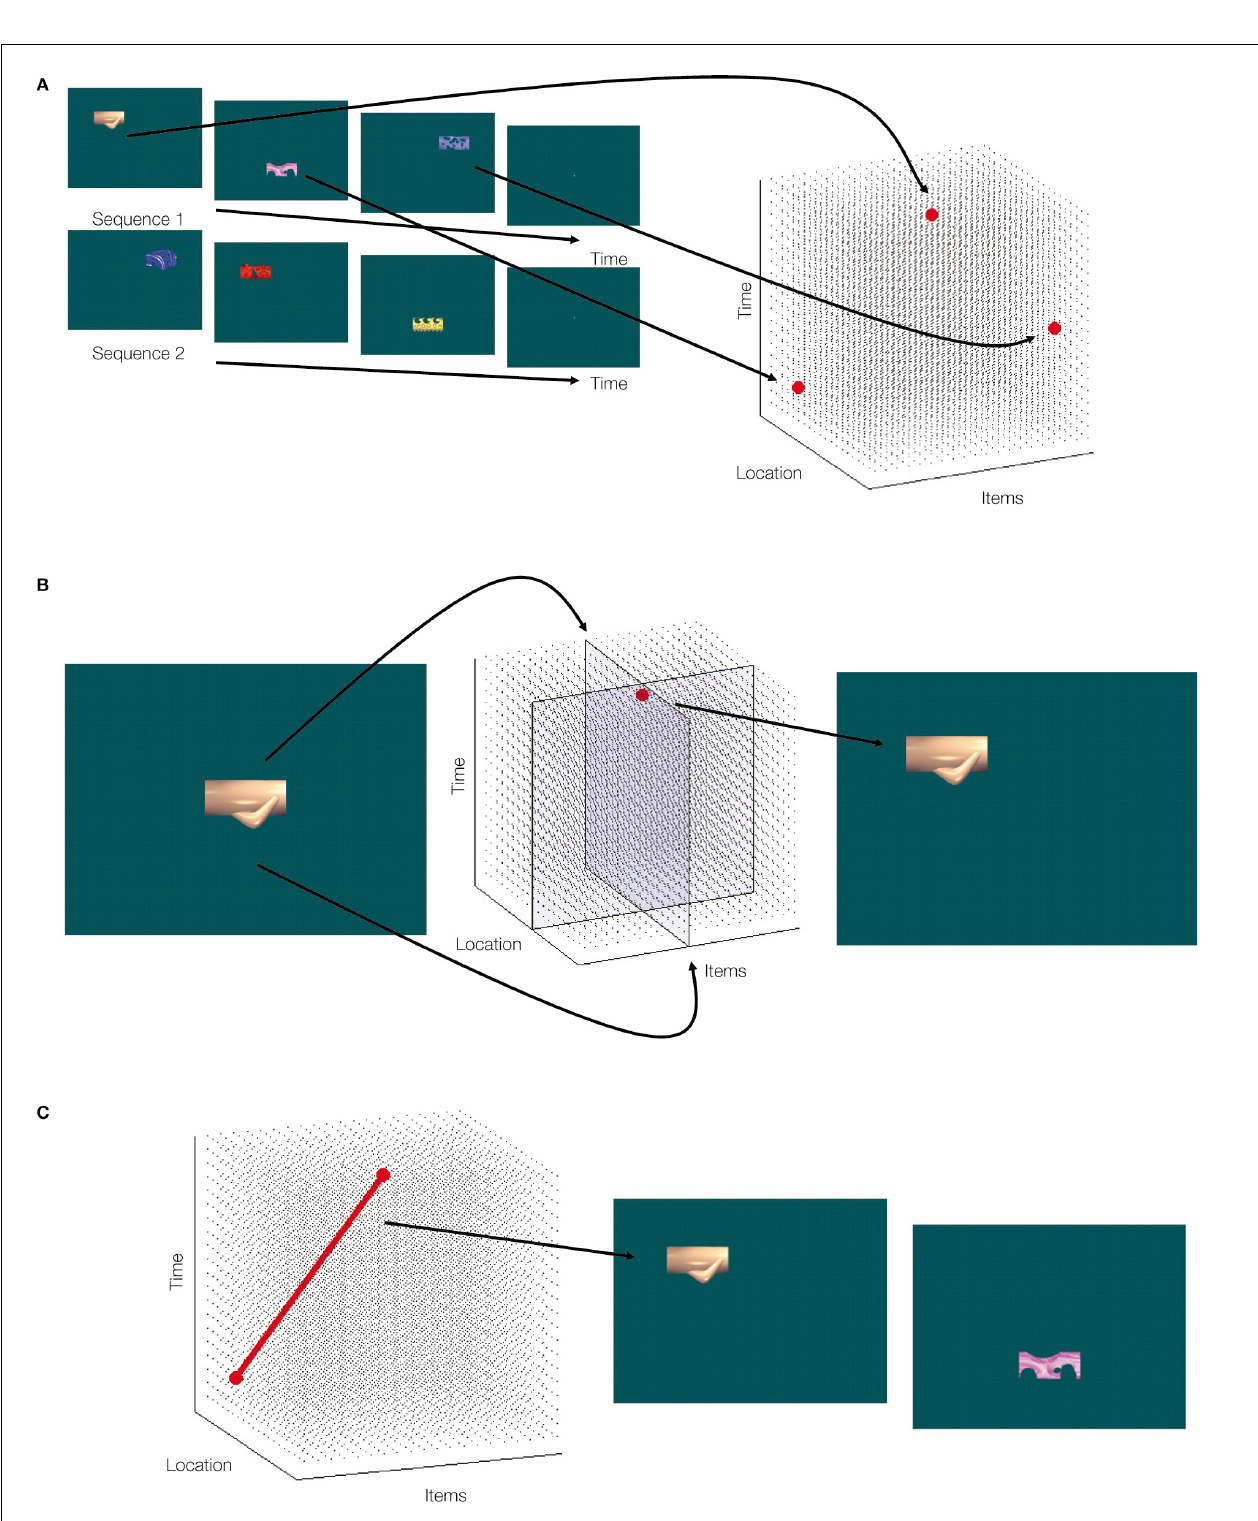
(e.g., where was this item studied?), the item together with the source probe constrains or limits the space to be searched, aiding retrieval of the relevant information (i.e., activation of the relevant node). (C) Activation of a given node in the space may also lead to reactivation of related nodes (here, retrieving the next item and location in the